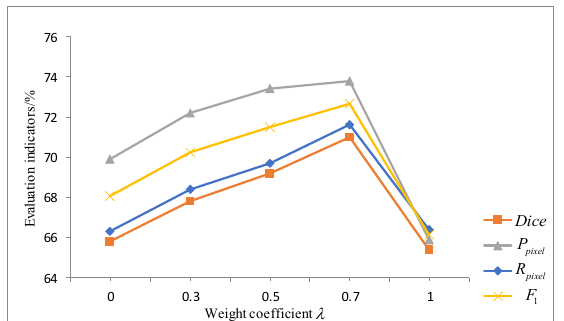
Figure 8. Experimental results of hybrid loss functions with different weight coefficients.